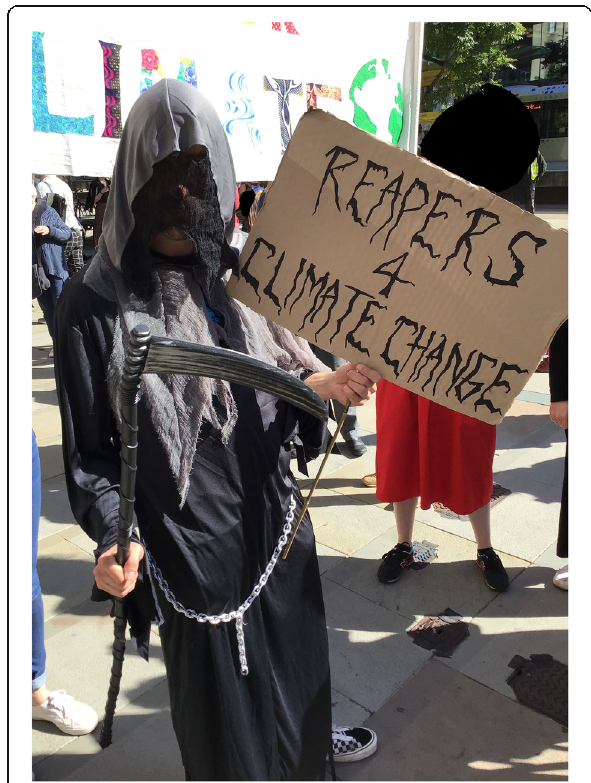
Fig. 4 Protest ensemble: 'REAPERS 4 CLIMATE CHANGE'